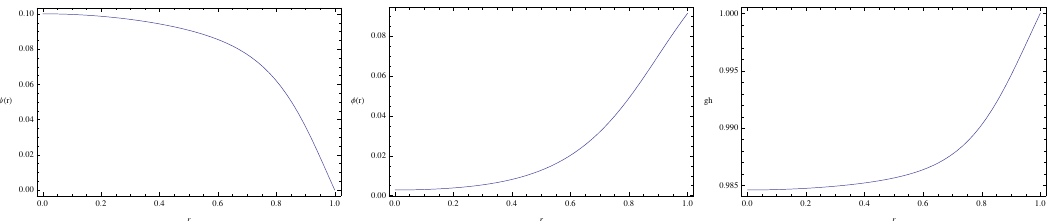
Figure 1 . (Color online) We plot solutions as a function of the radial coordinate r with q = 100, m 2 = − 2, C 4 = 0 and ψ (0) = 0 . 1. The left panel shows behaviors of ψ ( r ), the middle panel corresponds to the vector field φ ( r ) and the right panel represents the values of g ( r ) h ( r ) = − g tt ( r ).